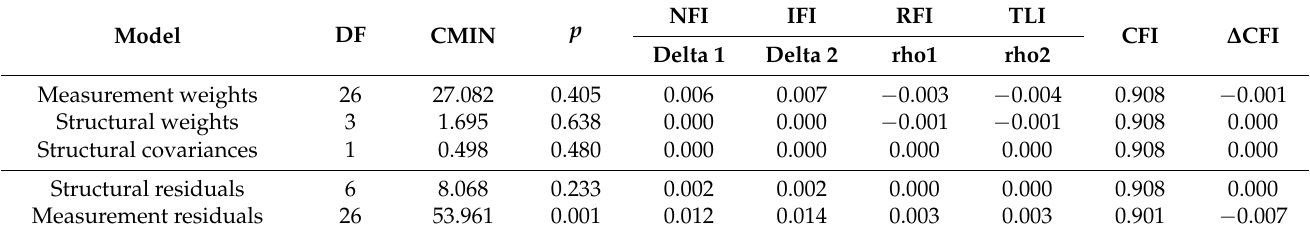
Table 6. Comparison of structural models without deformation for different gender